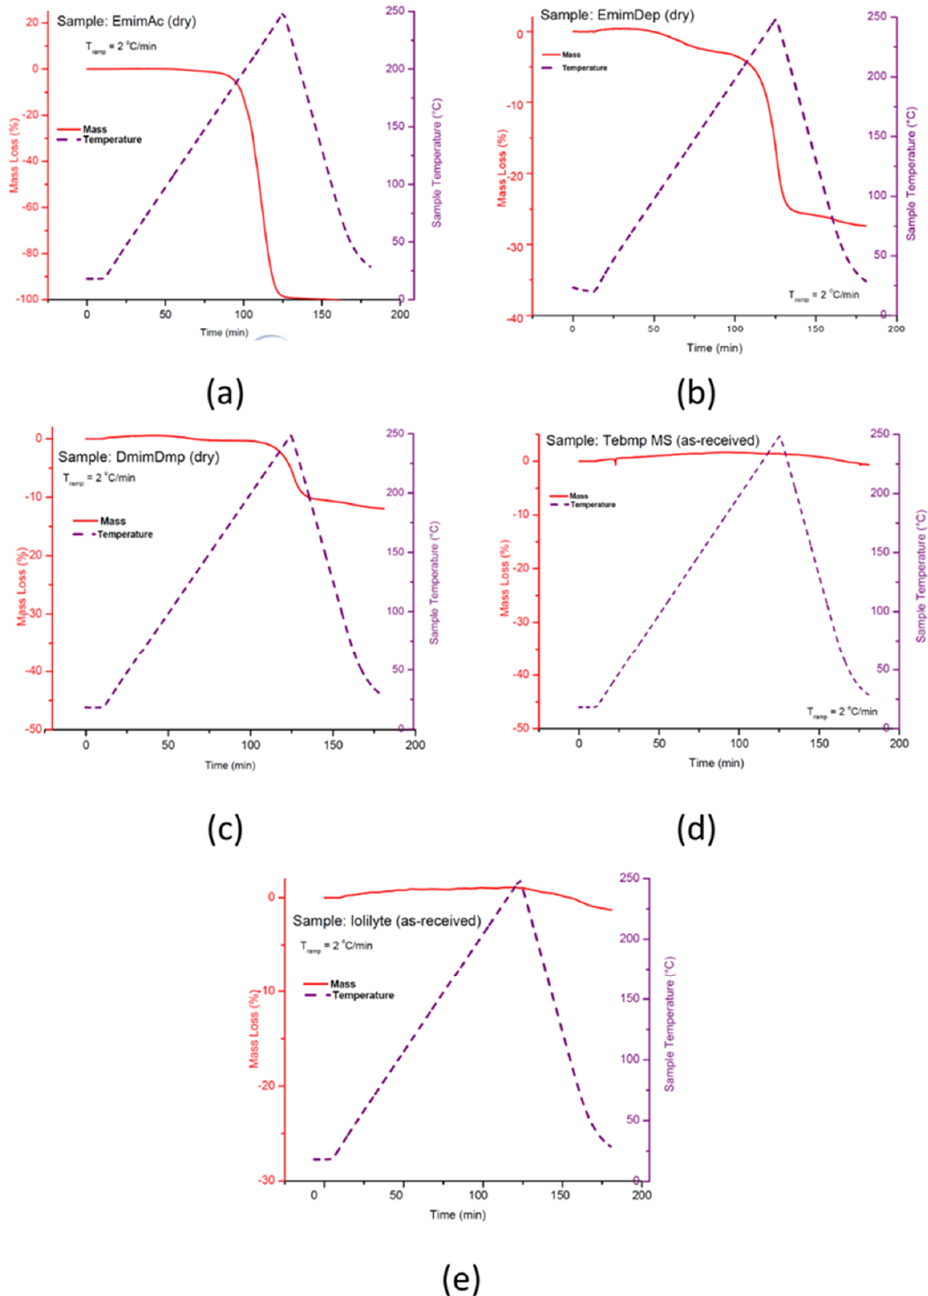
Figure 26. TG decompositions curves of neat ionic liquids for ( a ) EmimAc, ( b ) EmimDep, ( c ) DmimDmp, ( d ) TbmpMs, and ( e ) IoLiLyte. Reproduced from [28].